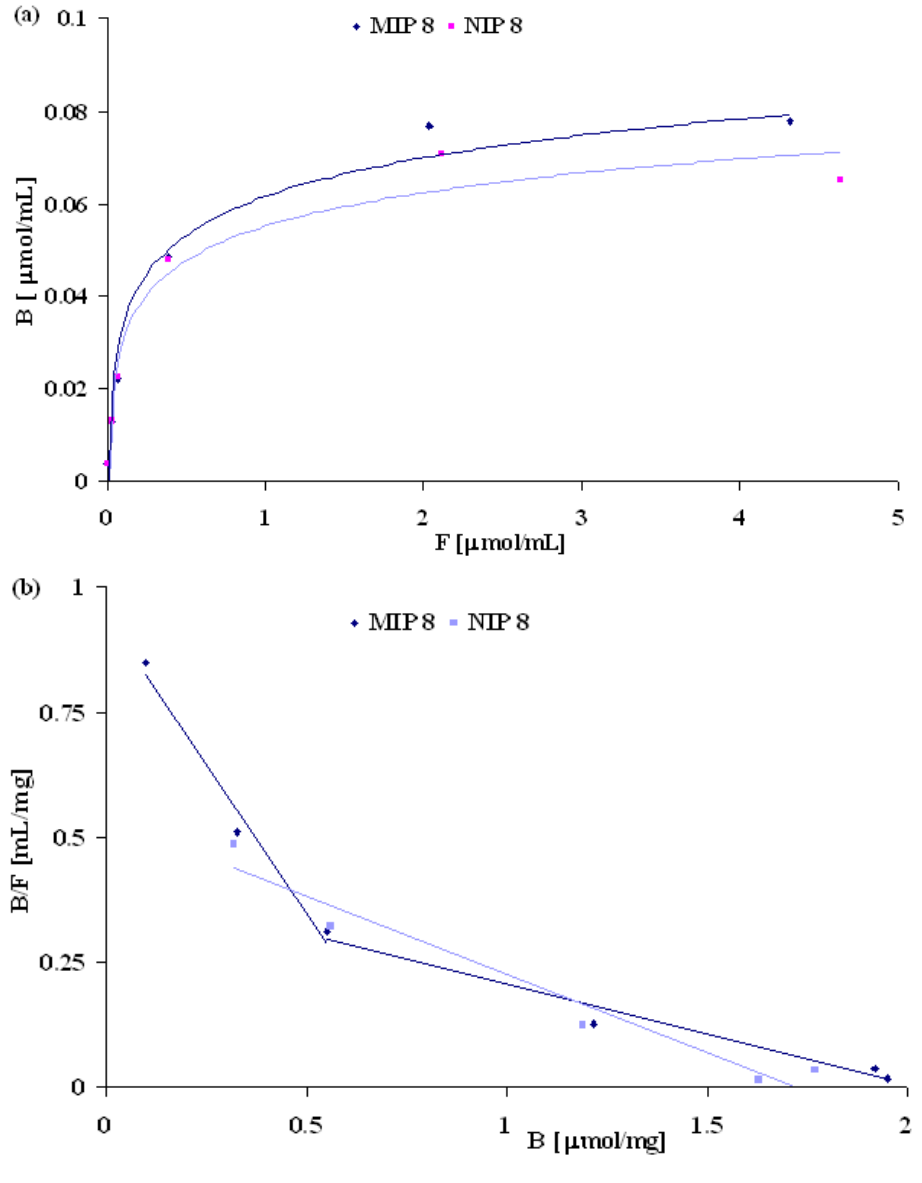
Figure 6 . Binding isotherms and Scatchard plots obtained for MIP8 and NIP8